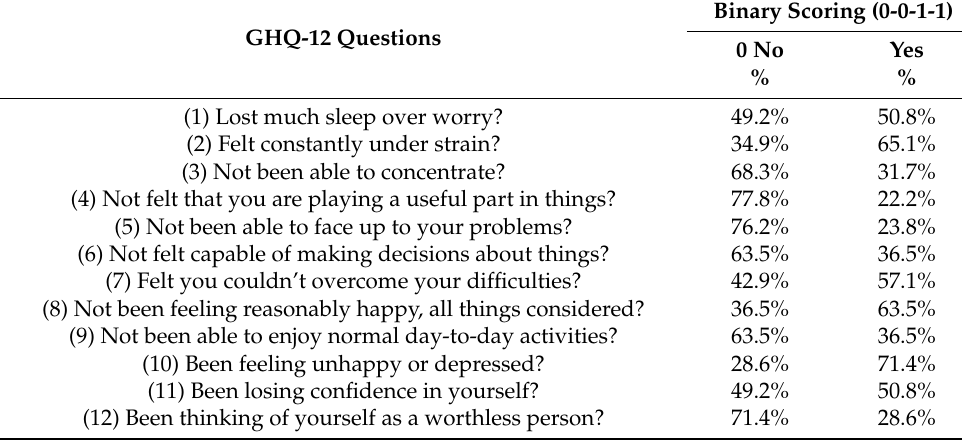
Table 4. The GHQ-12 scores ( n =